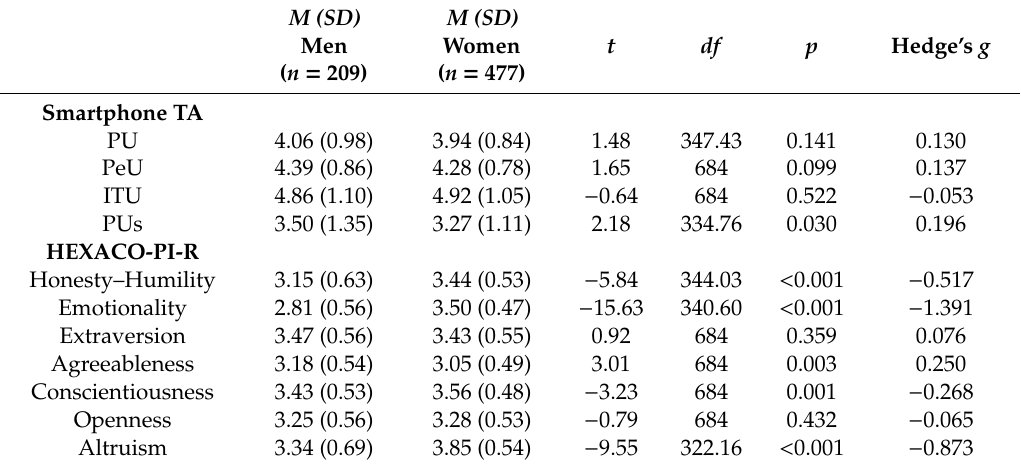
Table 1. Mean values and standard deviations ( SD s) of all scales of interest separately for men and women as well as results of t -tests on di ff erences between